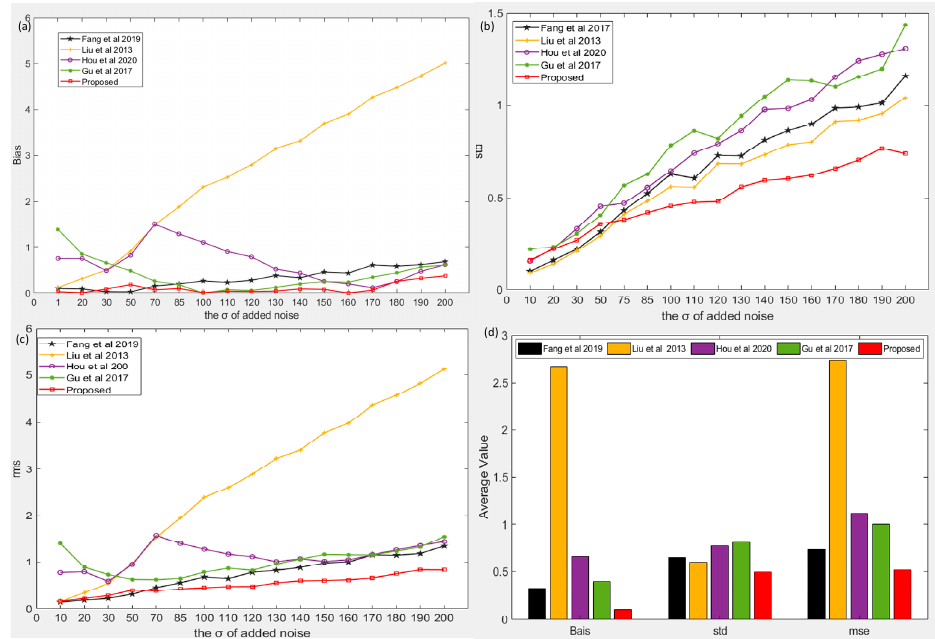
Figure 3. Comparison of the results of our algorithm and four existing algorithms [34,36,38,49] under Set12 dataset. ( a ) the bias of noise estimation results of five algorithm under different noise levels, ( b ) the std of noise estimation results of five algorithm under different noise levels, ( c ) the mse of noise estimation results of five algorithm under different noise levels, ( d ) the average value of noise estimation results of five algorithm under different noise levels.